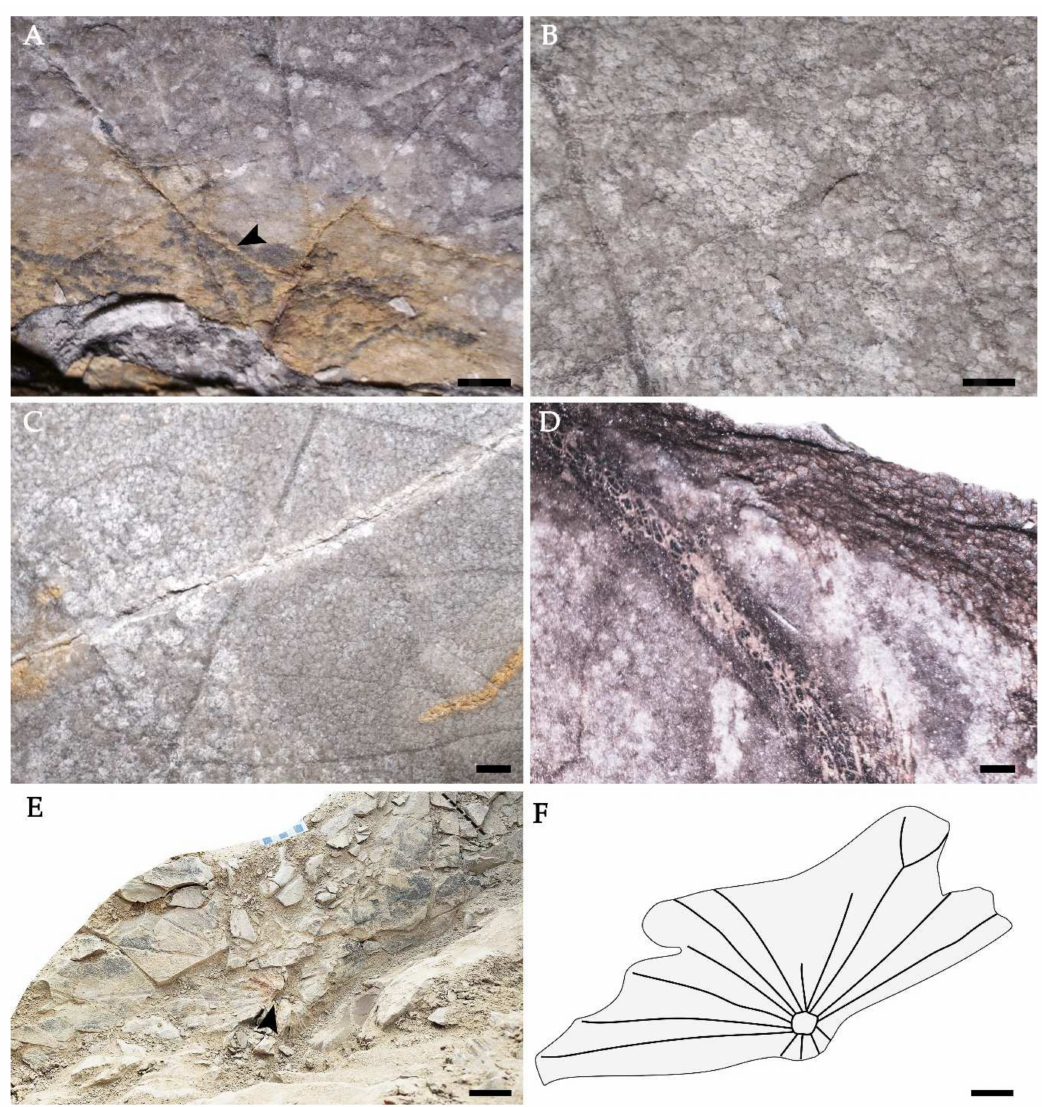
Figure 3. Enlarged part of the leaves of Figure 1 and the leaf of Nelumbo delinghaensis in situ and its line drawing. ( A ) The position of the bifurcation and poorly-developed secondary veins (black arrow). DLH550, scale bar = 5 mm. ( B , C ) Enlarged part of Figure 2A showing small areoles. DLH550, scale bar = 1mm. ( D ) Enlarged part of Figure 2E, scale bar = 1 mm. ( E ) Leaf of Nelumbo delinghaensis in situ, noting the leaf center (black arrow) and incomplete margin. ( F ) Interpretative outline drawing of N. delinghaensis in situ, scale bar = 50